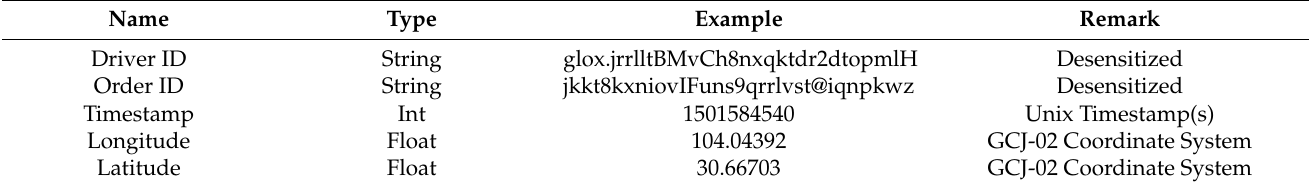
Table 2. An example of the trajectory